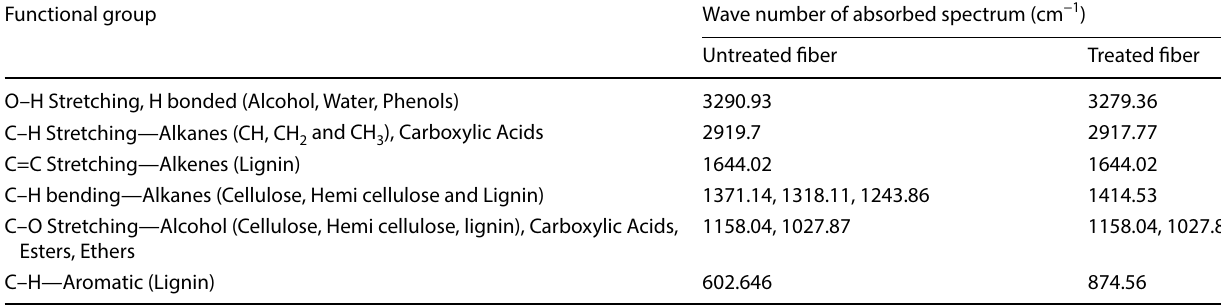
Table 6 FTIR spectrum and its characteristics of untreated and treated caryotta obtusa fiber Functional